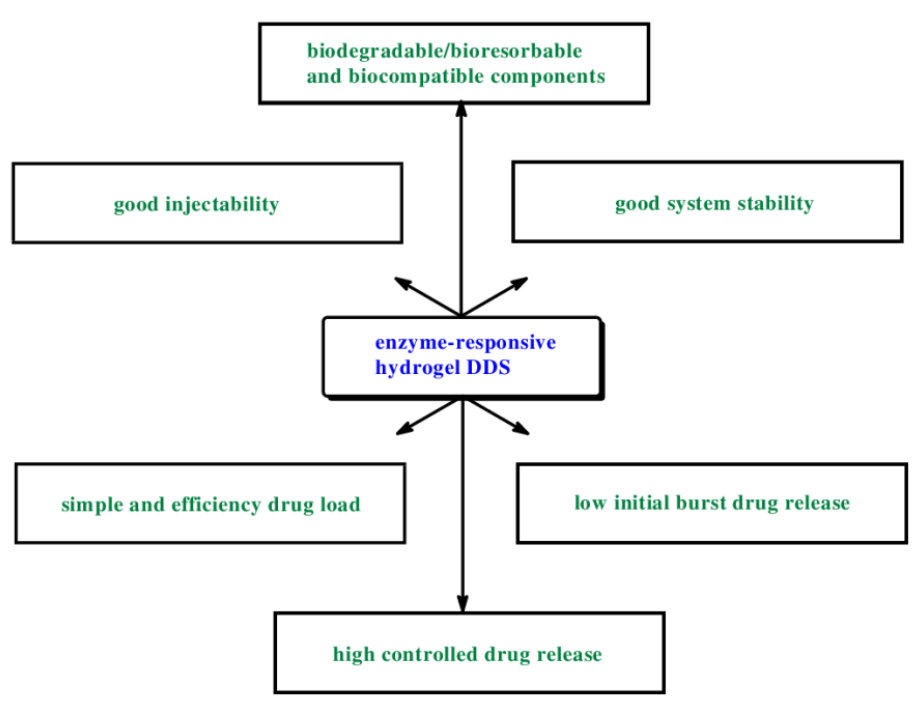
Figure 7. An ideal enzyme-responsive hydrogel drug delivery system.